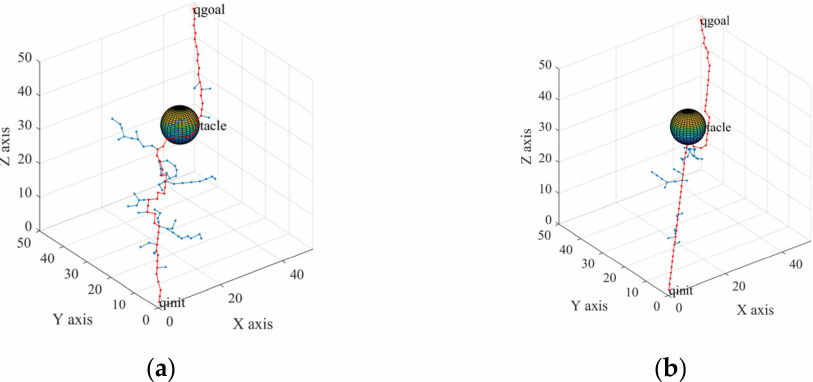
Figure 2. Threshold comparison. ( a ) Constant probability threshold; ( b ) Adaptive probability threshold.